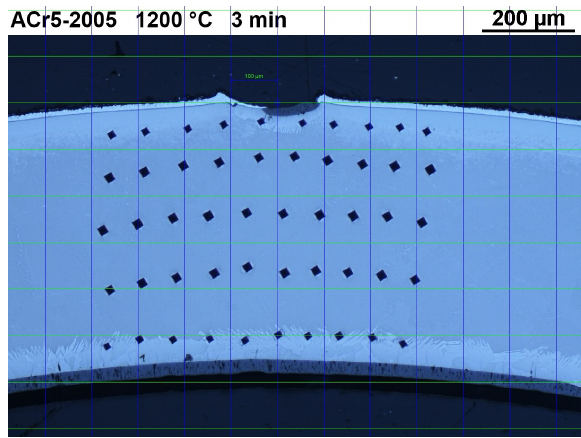
Figure 7. Microhardness indents in 5 vertical lines.